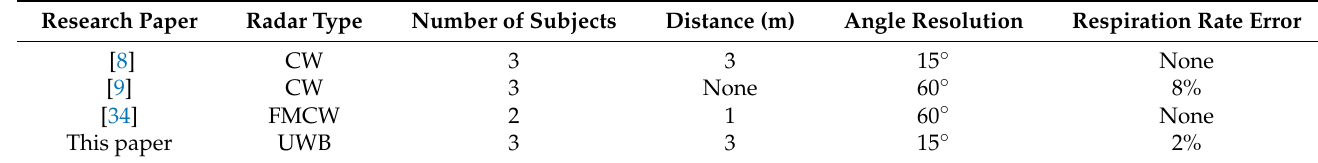
Table 1. Comparison with the state-of-the-art